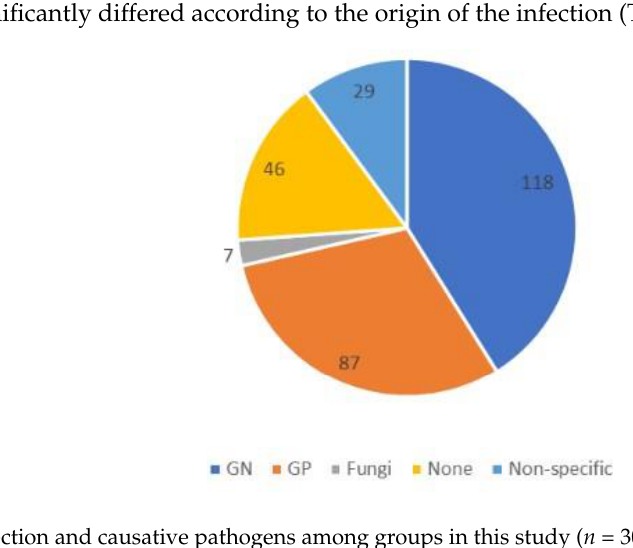
Figure 1. Origin of infection and causative pathogens among groups in this study ( n = 307). Abbrevi- ations: L, lung; U, urinary tract; A, abdomen; S, soft tissue; C, central nervous system; E, endocardial systems; V, various other organs, including multiple infectious origins and cases of unknown origin.